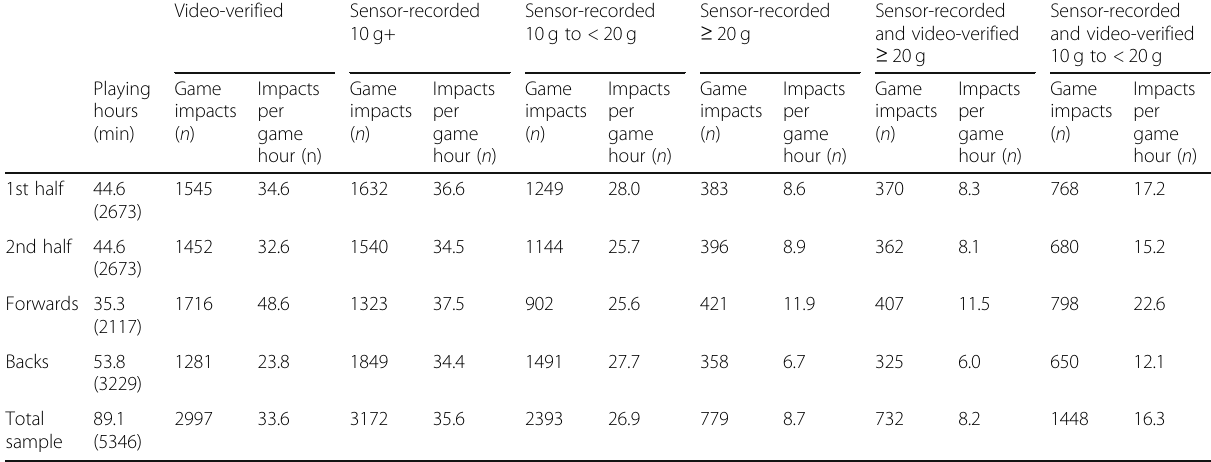
Table 1 Frequency of video-verified impacts by game time and playing position